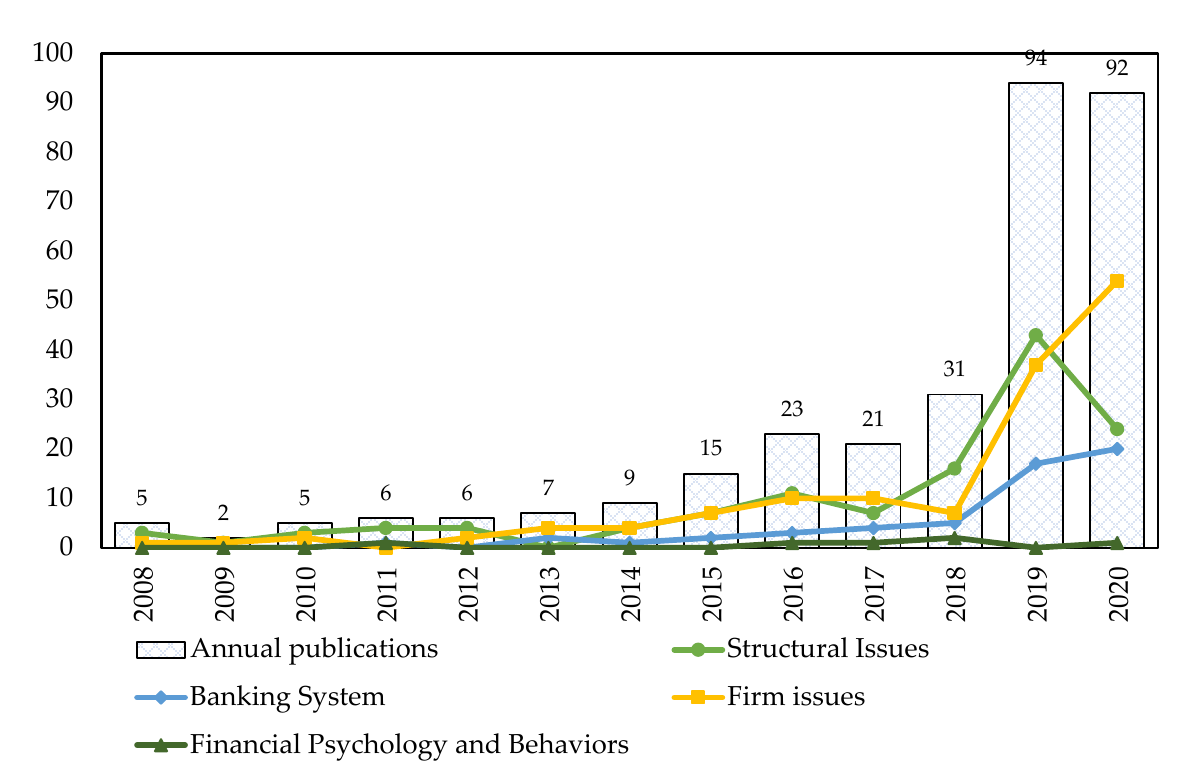
Figure 3. The number of published articles related to Finance in the SSHPA database, 2008–2020.